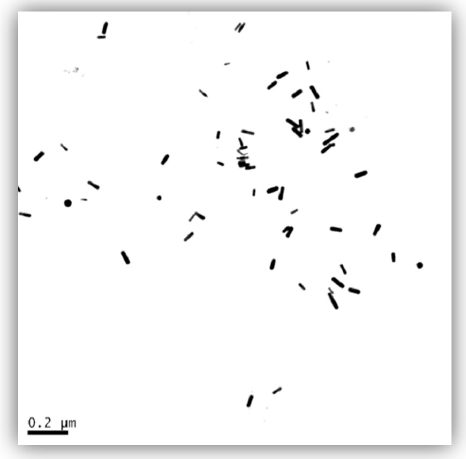
Figure 1. Transmission electron microscopy image of gold nanorods ( GNRs).